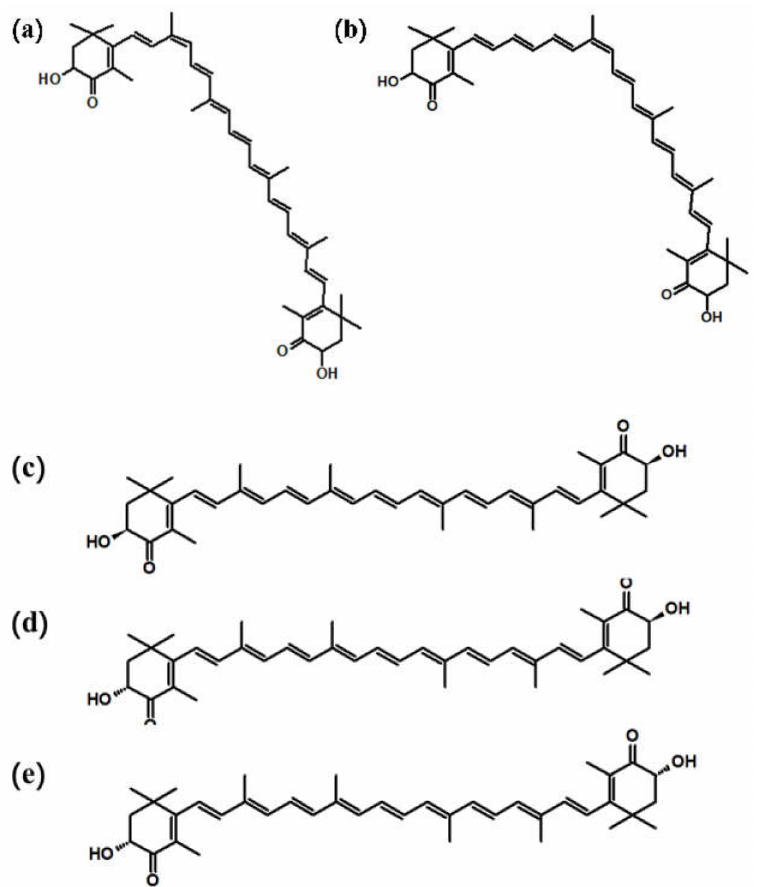
Figure 1. ( a ) 9-cis astaxanthin; ( b ) 13-cis astaxanthin; ( c ) 3S, 3 (cid:48) S astaxanthin;( d ) 3R, 3 (cid:48) S astaxanthin; ( e ) 3R, 3 (cid:48) R